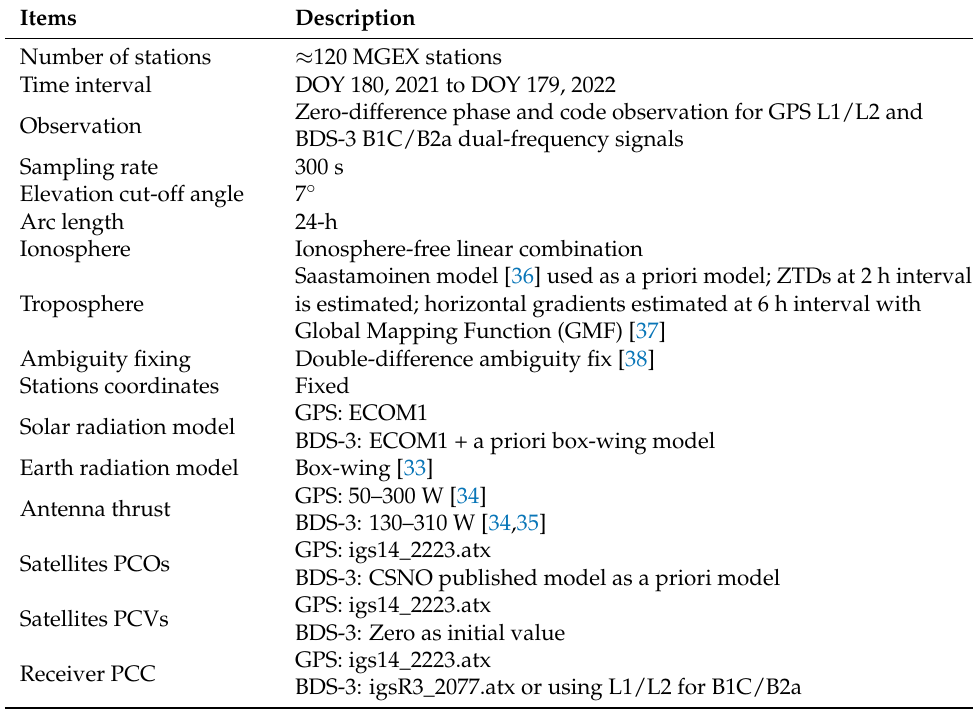
Table 1. Data processing